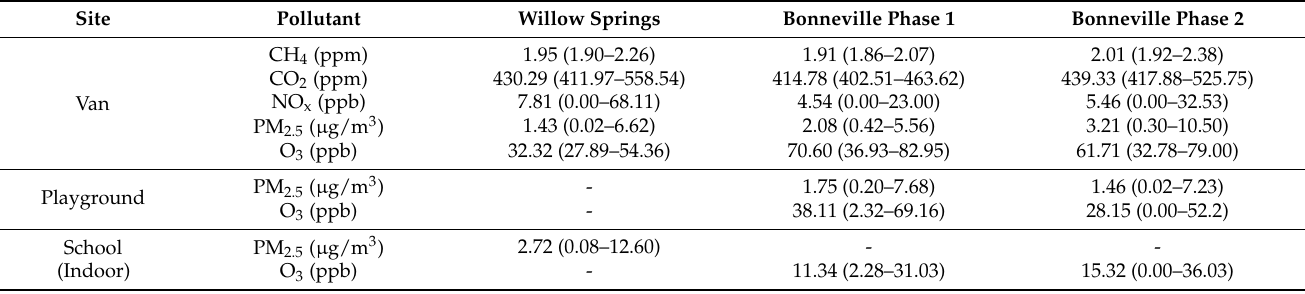
Table 2. Hourly mean and range (minimum–maximum) pollutant readings for each